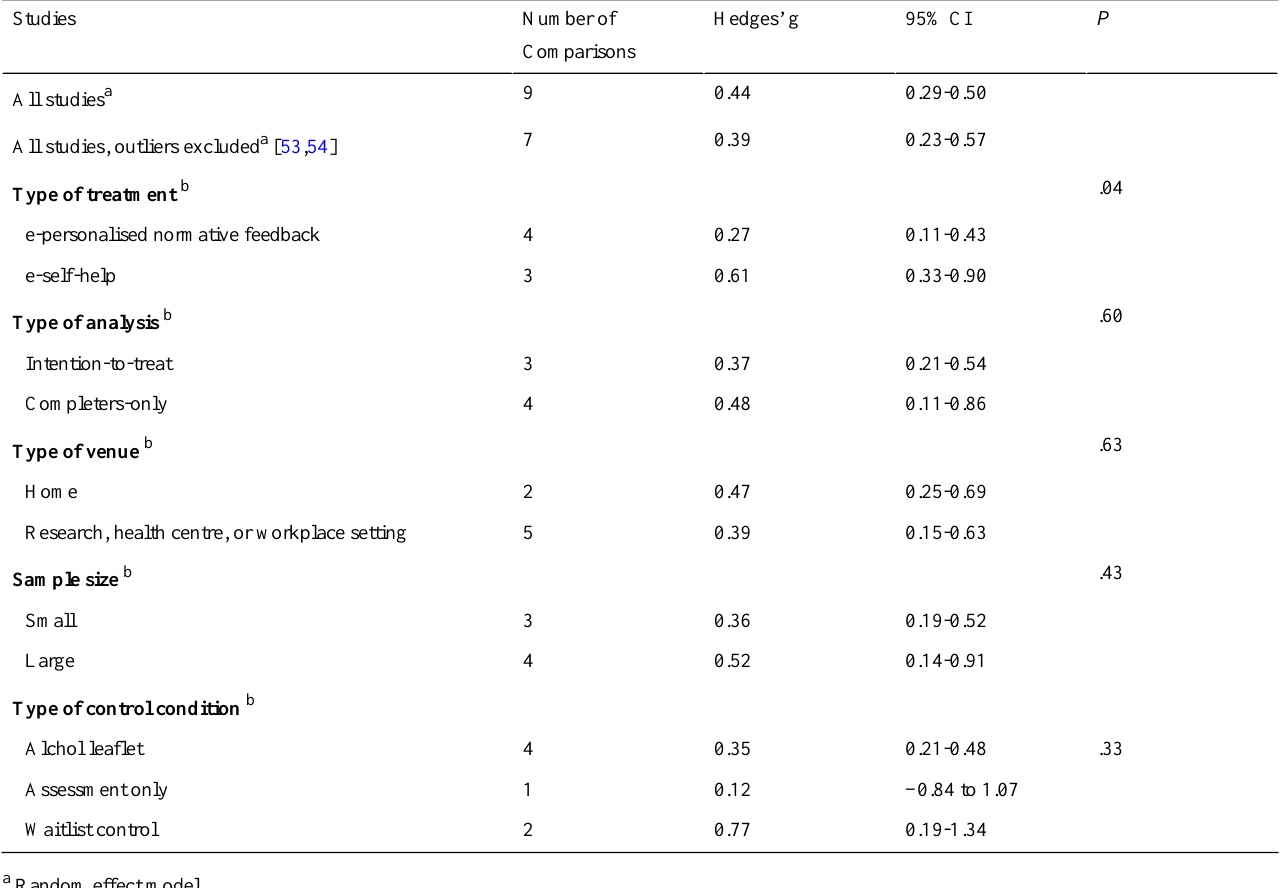
Table 2. Effect sizes of e-interventions for problem drinking versus control conditions